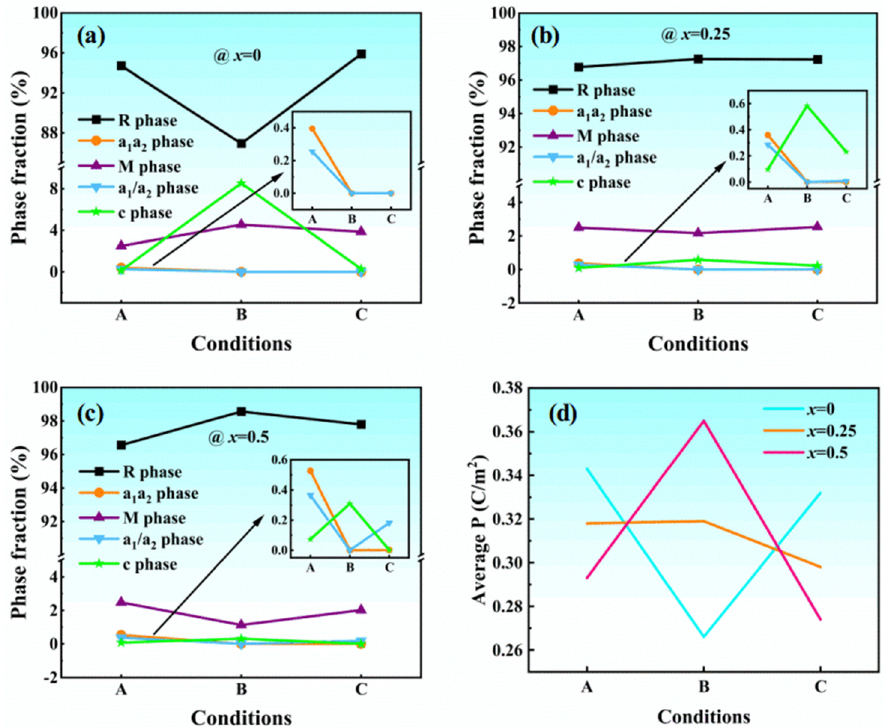
Figure 1. The phase states and average polarization dependence on electric fields. The conditions A, B, and C represent the initial state, loading the maximum electric field, and unloading the electric field, respectively. ( a ) KNbO 3 ; ( b ) K 0.75 Na 0.25 NbO 3 ; ( c ) K 0.5 Na 0.5 NbO 3 ; and ( d ) the average polarization of different conditions.